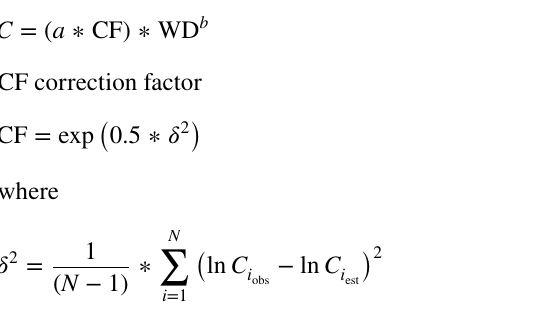
Table 1 Performance results of the suspended sediment at different time scales